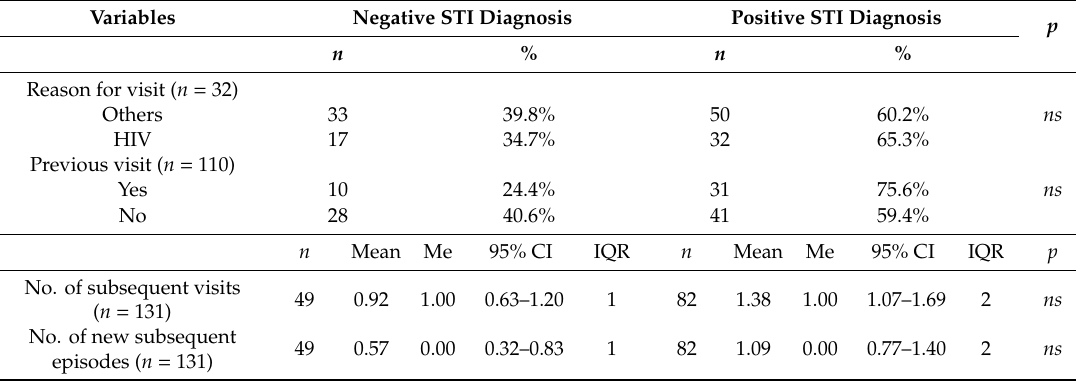
Table 3. STI diagnosis vs. Healthcare